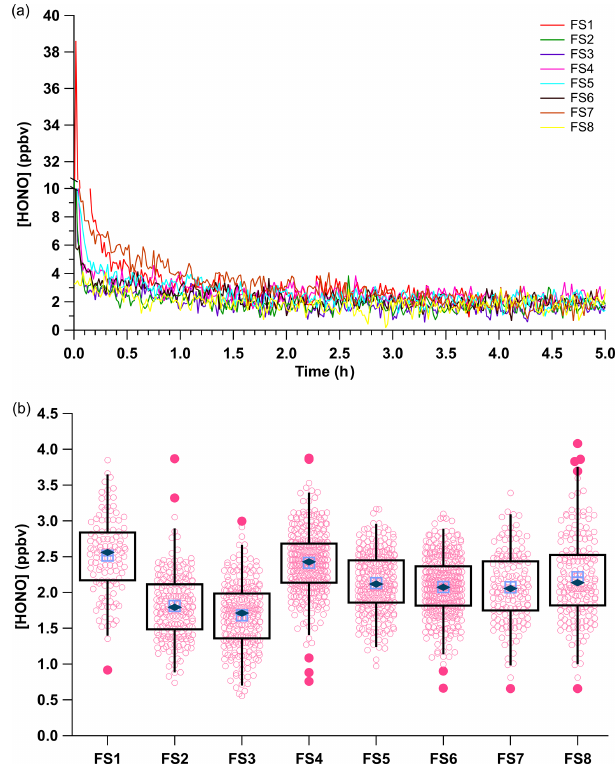
Figure 5. (a) Mixing ratios of HONO for the eight field transport simulations (FS, Table S1). All observations were background cor- rected by linear interpolation across the experiments using zero air before and after HONO observations and an Na 2 CO 3 -coated annu- lar during (Fig. S4). (b) Box and whiskers plot of the HONO output using measurements collected after 2h of calibration source stabi- lization. The light blue crossed box represents the median, the dark blue diamond the mean, light pink circles the data points, dark pink circles the 3 σ outliers, and the black box the first and third quar- tiles of observed HONO mixing ratios. The whiskers denote the 3 σ standard